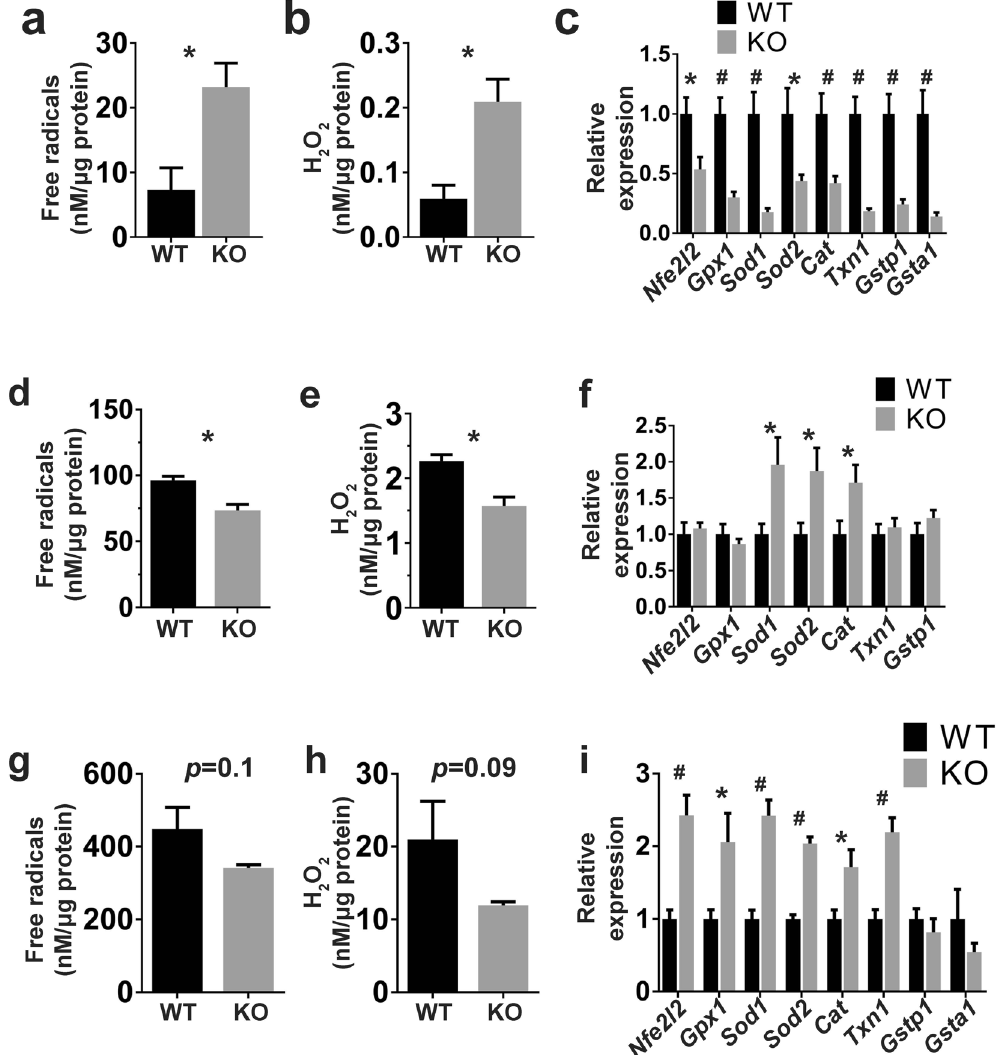
Figure 5. Hypothyroidism produces oxidative stress in the thyroid and a less oxidative intracellular environment in BAT and liver. ( a , b ) Quantitation of FR and H 2 O 2 levels in thyroid extracts from WT and NIS KO mice. ( c ) Expression of genes involved in FR metabolism in the thyroid (n = 7–8). ( d , e ) Quantitation of FR and H 2 O 2 levels in BAT extracts. ( f ) Expression of genes involved in FR metabolism in BAT. ( g , h ) Quantitation of FR and H 2 O 2 levels in liver extracts. ( i ) Expression of genes involved in free radical metabolism in the liver. Each group contained 4–5 males and 2–3 females fed a MID. Nfe2l2 = nuclear factor, erythroid 2 like 2, Gpx1 = glutathione peroxidase 1, Sod 1 and 2 = superoxide dismutase 1 and 2, Cat = Catalase, Txn1 = thioredoxin 1, Gstp1 = glutathione S-transferase pi 1, and Gsta1 = glutathione S-transferase alpha 1. * Indicates p < 0.05, # p <